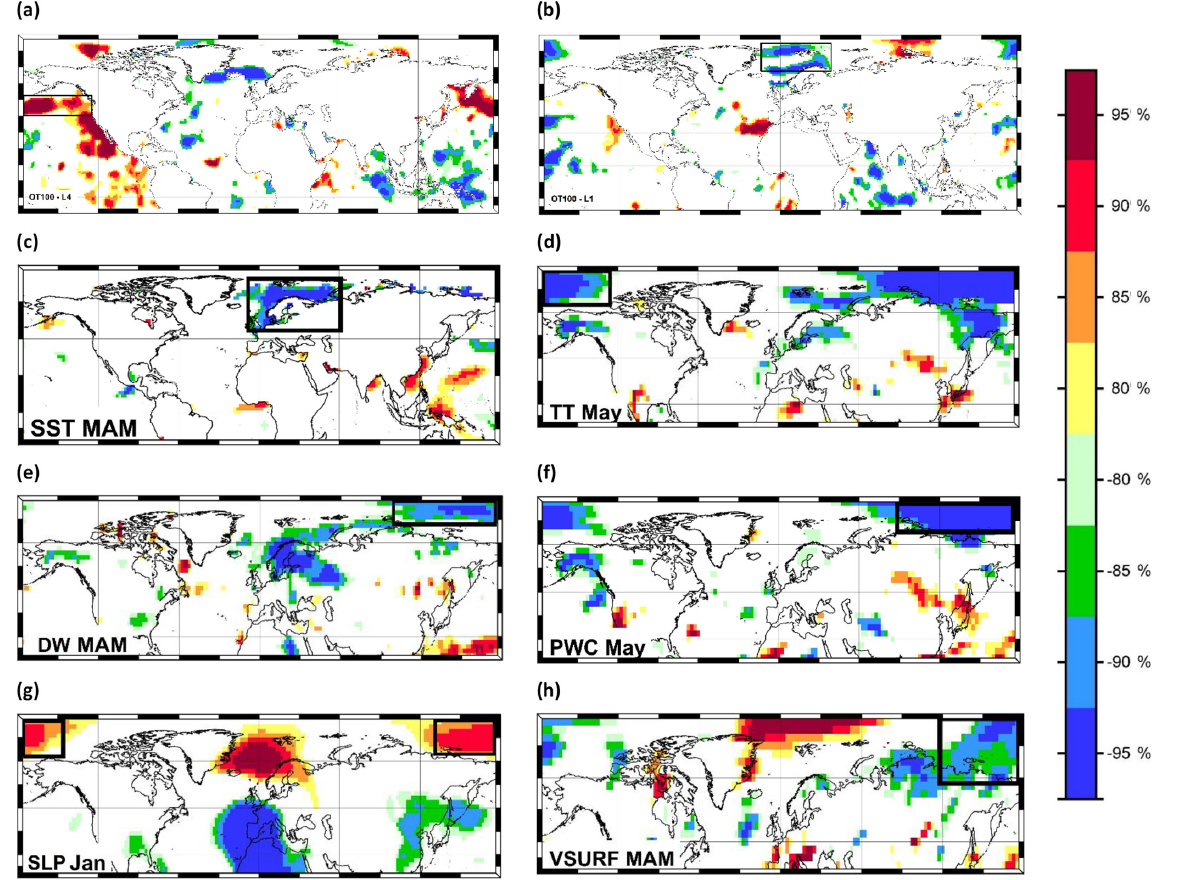
Figure 5. Stability map of the correlation between East Siberian September sea ice extent and (a) OT100 annual (L4), (b) OT100 annual (L1), (c) SST MAM, (d) TT May, (e) DW MAM, (f) PWC May, (g) SLP Jan and (h) VSURF MAM. Regions where the correlation is stable, positive and significant for at least 80% of the 21-year windows are shaded with dark red (95%), red (90%), orange (85%) and yellow (80%). The corresponding regions where the correlation is stable, but negative, are shaded with dark blue (95%), blue (90%), green (85%) and light green (80%). The black boxes indicate the regions used for the September sea ice extent at the end of May.